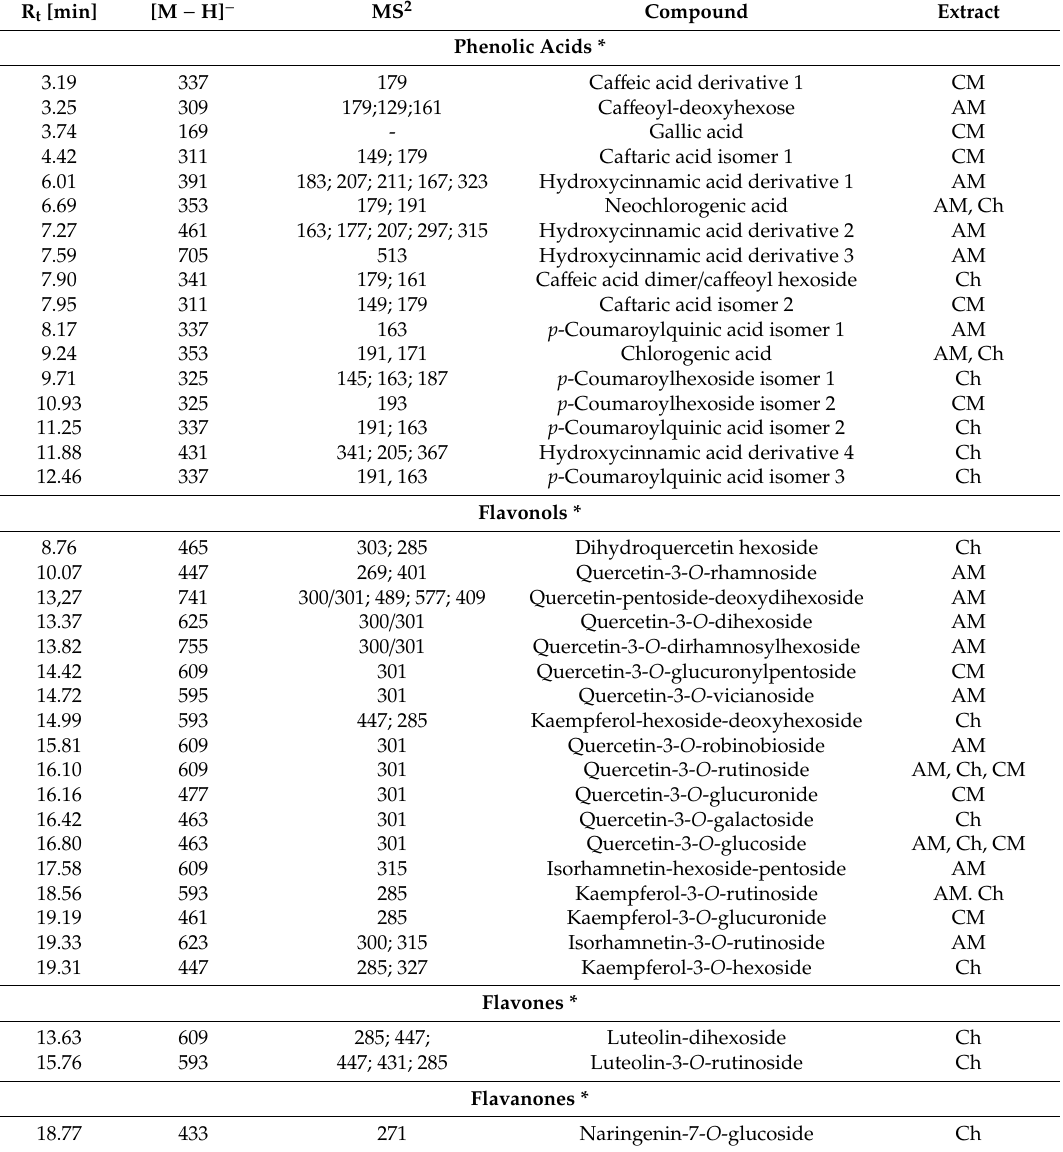
Table 2. Identification of polyphenols and iridoids in leaf